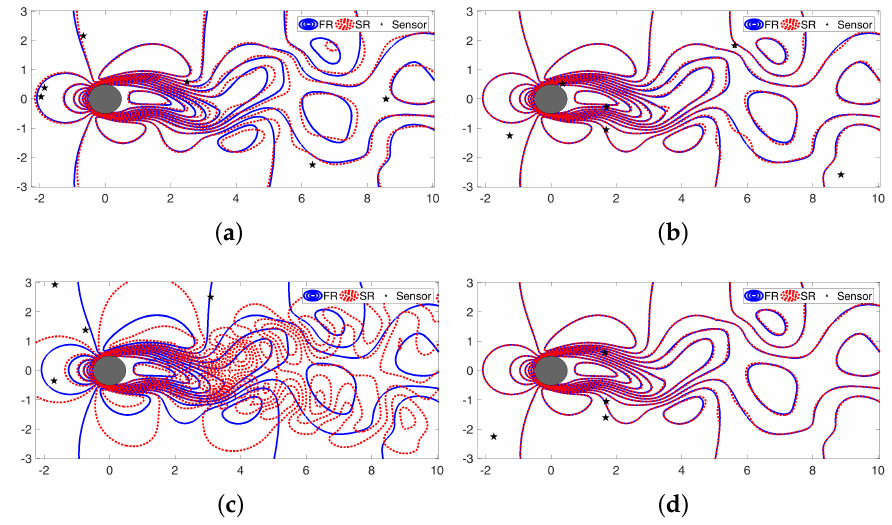
Figure 9. Comparison of POD-based SR and full reconstruction (FR) for different random sensor placement and P ∗ ≤ K ∗ . Blue solid line: FR. Red dashed line: SR. Black stars: sensor locations. ( a ) Seed = 101 (at P ∗ = 3 and K ∗ = 3); ( b ) Seed = 102 (at P ∗ = 3 and K ∗ = 3); ( c ) Seed = 108 (at P ∗ = 2 and K ∗ = 3); and ( d ) Seed = 109 (at P ∗ = 2 and K ∗ = 3).